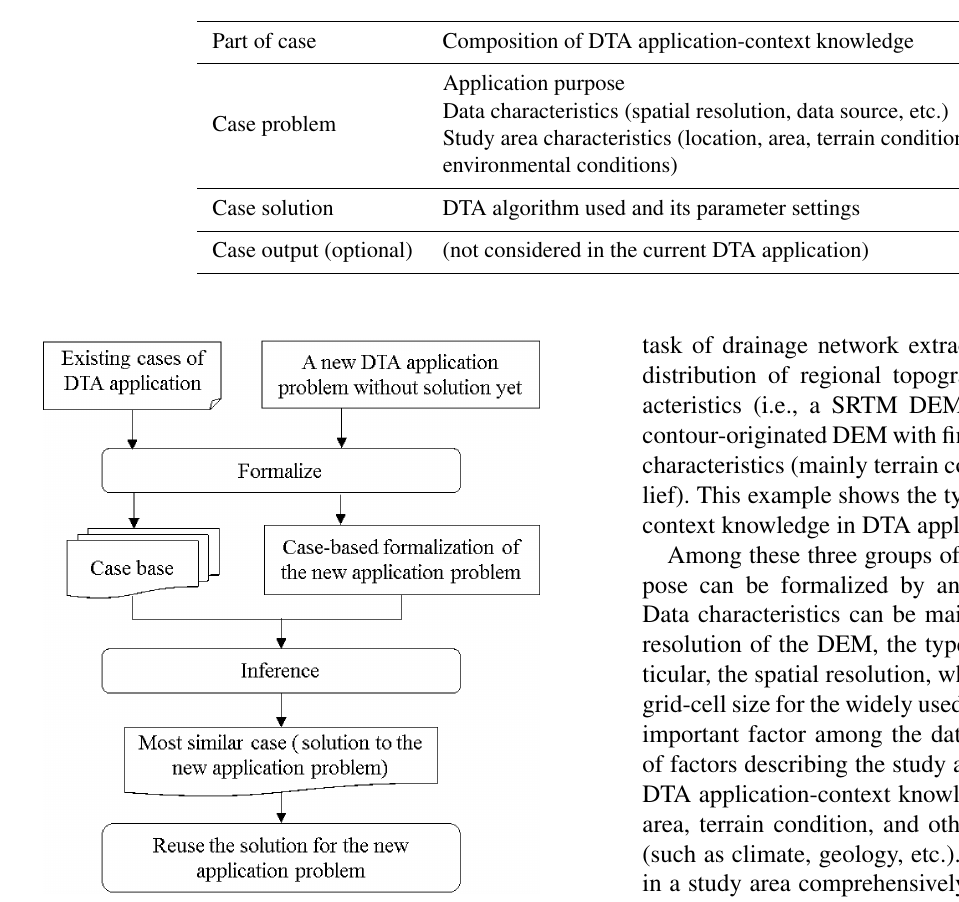
Table 1. General composition of DTA application-context knowledge in a case-based formalization.